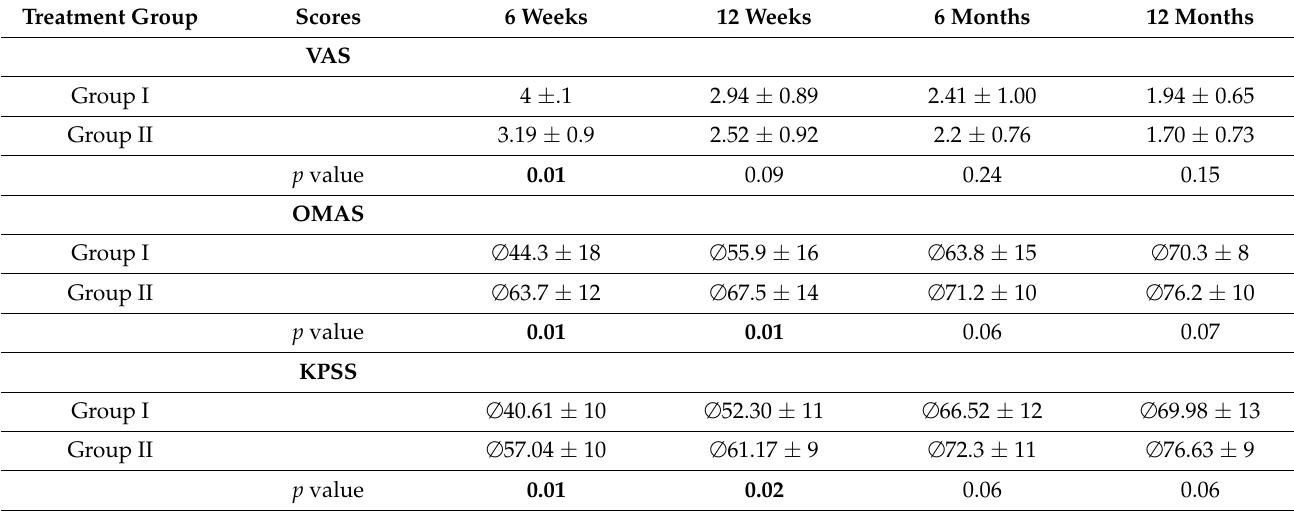
Table 4. Functional Ankle Scoring was assessed using VAS, OMAS, and KPSS for both treat- ment/patient groups separately at 6 and 12 weeks as well as 6 and 12 months postoperatively. Results are given as ∅ mean and +/ − standard deviation. Group I was treated by DePuy Synthes one third semitubular, Group II with the IlluminOss ® Photodynamic Bone Stabilization System.